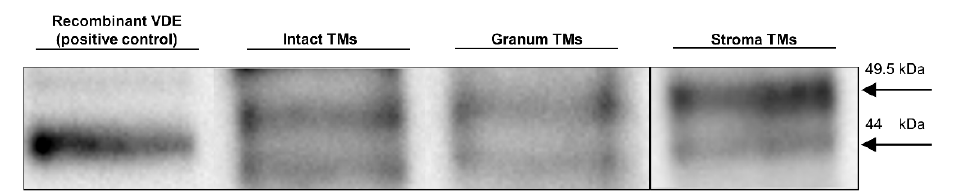
Figure 3. Immunoblotting of a recombinant VDE (positive control, with a MW slightly affected because of the His-tag) and VDE in intact TMs and in granum and stroma membrane particles. Proteins were separated and VDE detected using SDS-PAGE/western blotting. Total Chl contents loaded in the wells were 2 and 20 µ g for intact TMs subchloroplast particles, respectively. MW of the bands, 49.5 kDa (upper) and 44.0 kDa (lower). Images of two equally treated blots were processed for granum and stroma TMs. Exposure times: 38 s (intact and granum TMs) and 30 s (stroma TMs).